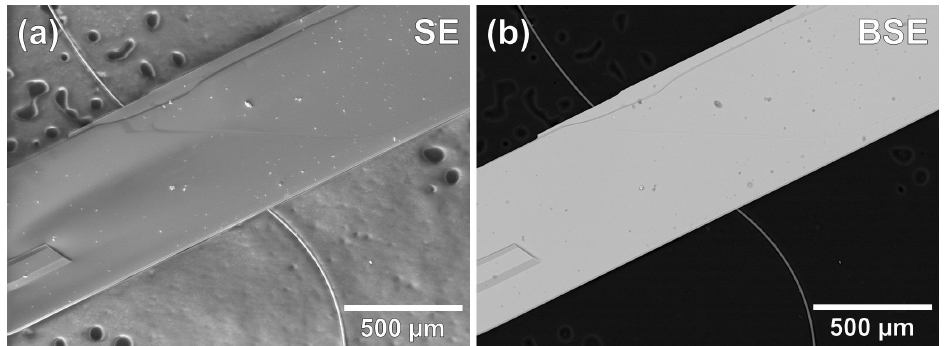
Figure 4. SEM image of a AgCrP 2 S 6 crystal with topographical contrast (SE mode) in ( a ) and chemical contrast (BSE mode) in ( b